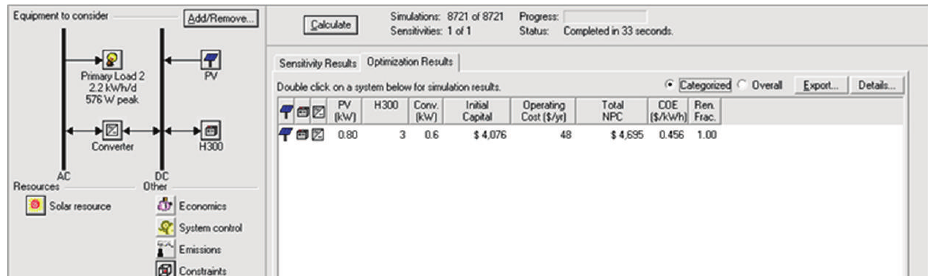
Figure 13: A capture of HOMER for the designed system.